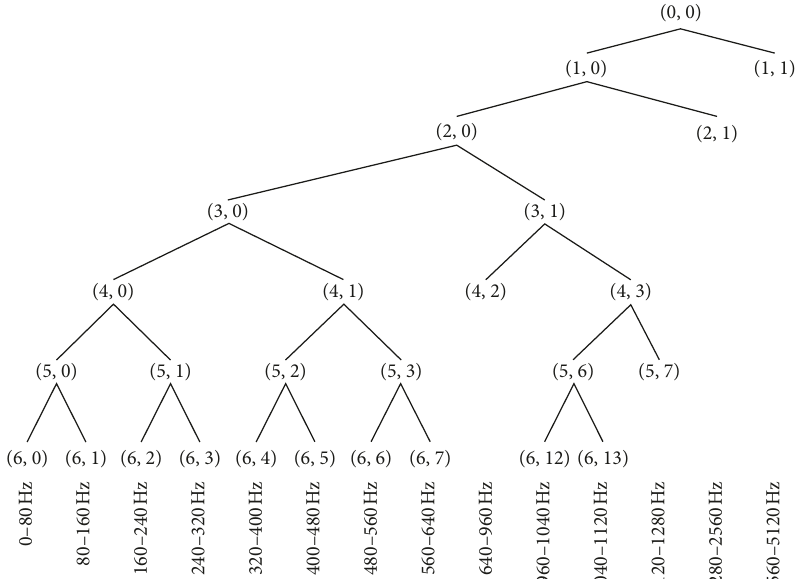
Figure 8: Optimal wavelet tree and corresponding frequency bands for each node.